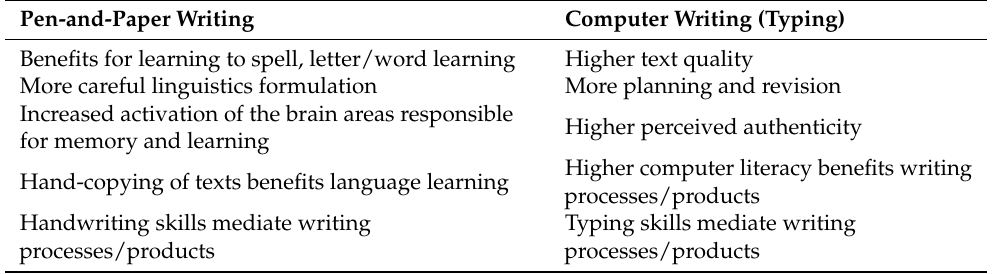
Table 3. Summary of some relevant empirical findings for pen-and-paper and computer